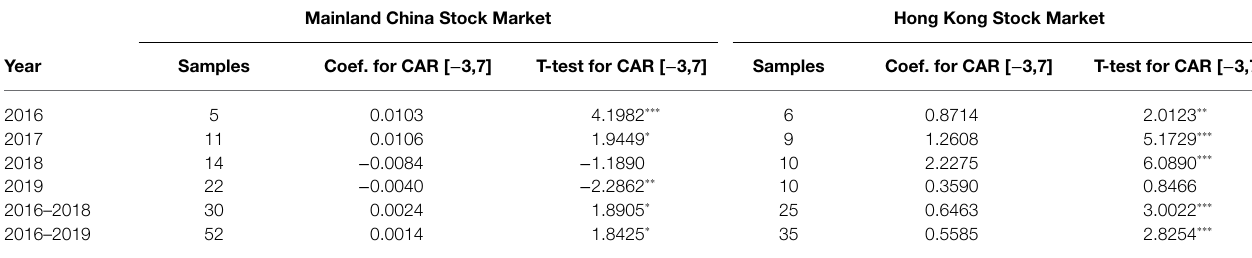
TABLE 2 | Green bonds CAR calculated in both